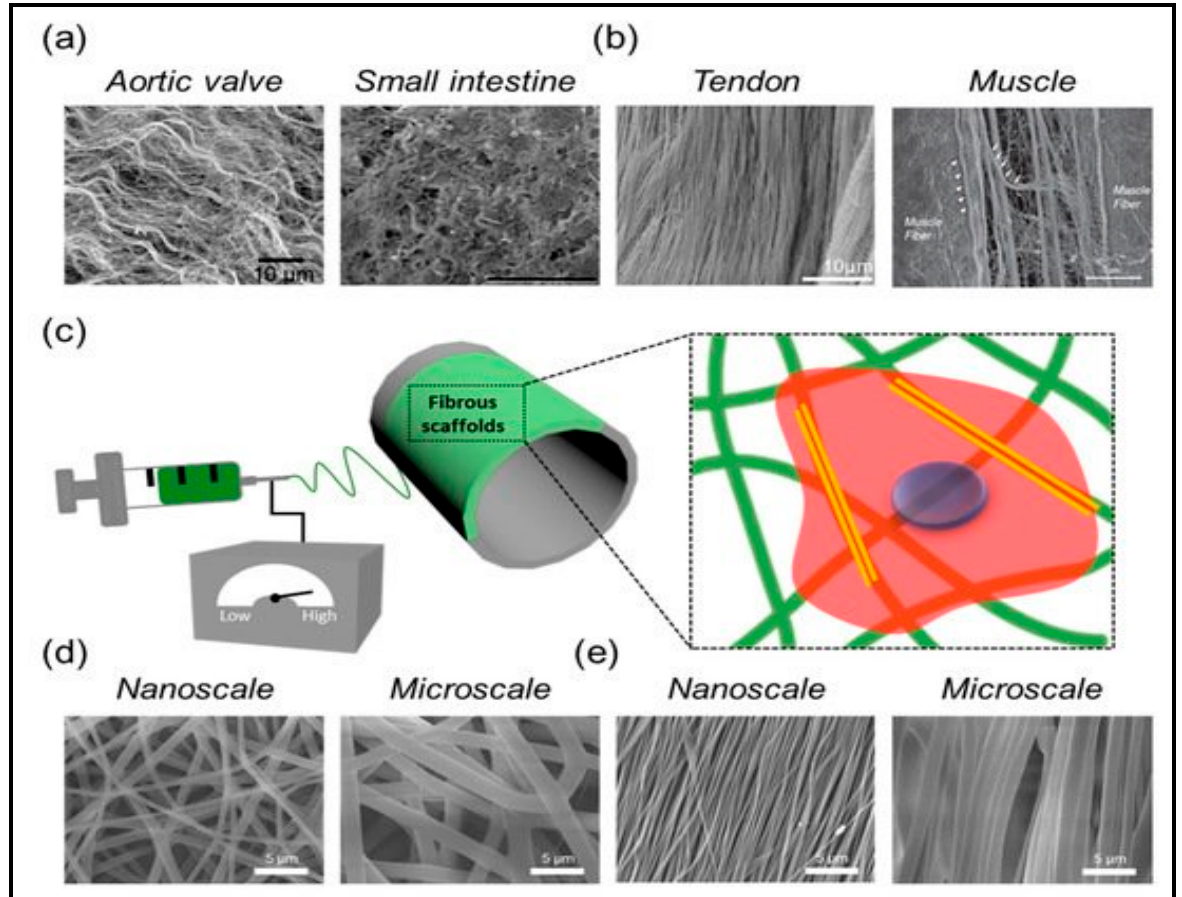
Figure 8. Pore structures of the tissue-engineered scaffold from fibre ( a ) aortic valve & small intestine ( b ) tendon & muscle ( c ) fibrous scaffold ( d ) nanoscale & microscale ( e ) nanoscale & microscale [107].